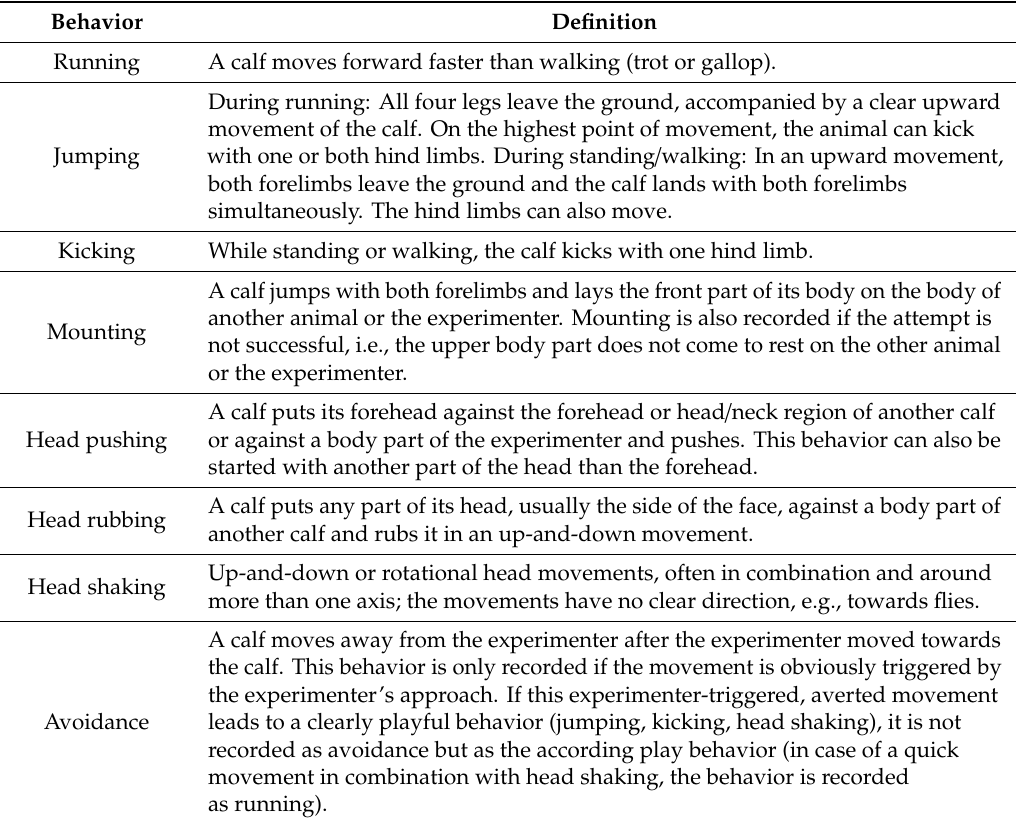
Table 1. Ethogram of observed behaviors. For running, head pushing and head rubbing, durations were recorded; all other behaviors were recorded as frequencies. Head shaking is a supplemental definition (to distinguish avoidance from playful running that is directed away from the experimenter) and was not recorded on its own, as it usually occurs together with running or jumping. All behaviors except for avoidance were considered play behaviors (described in